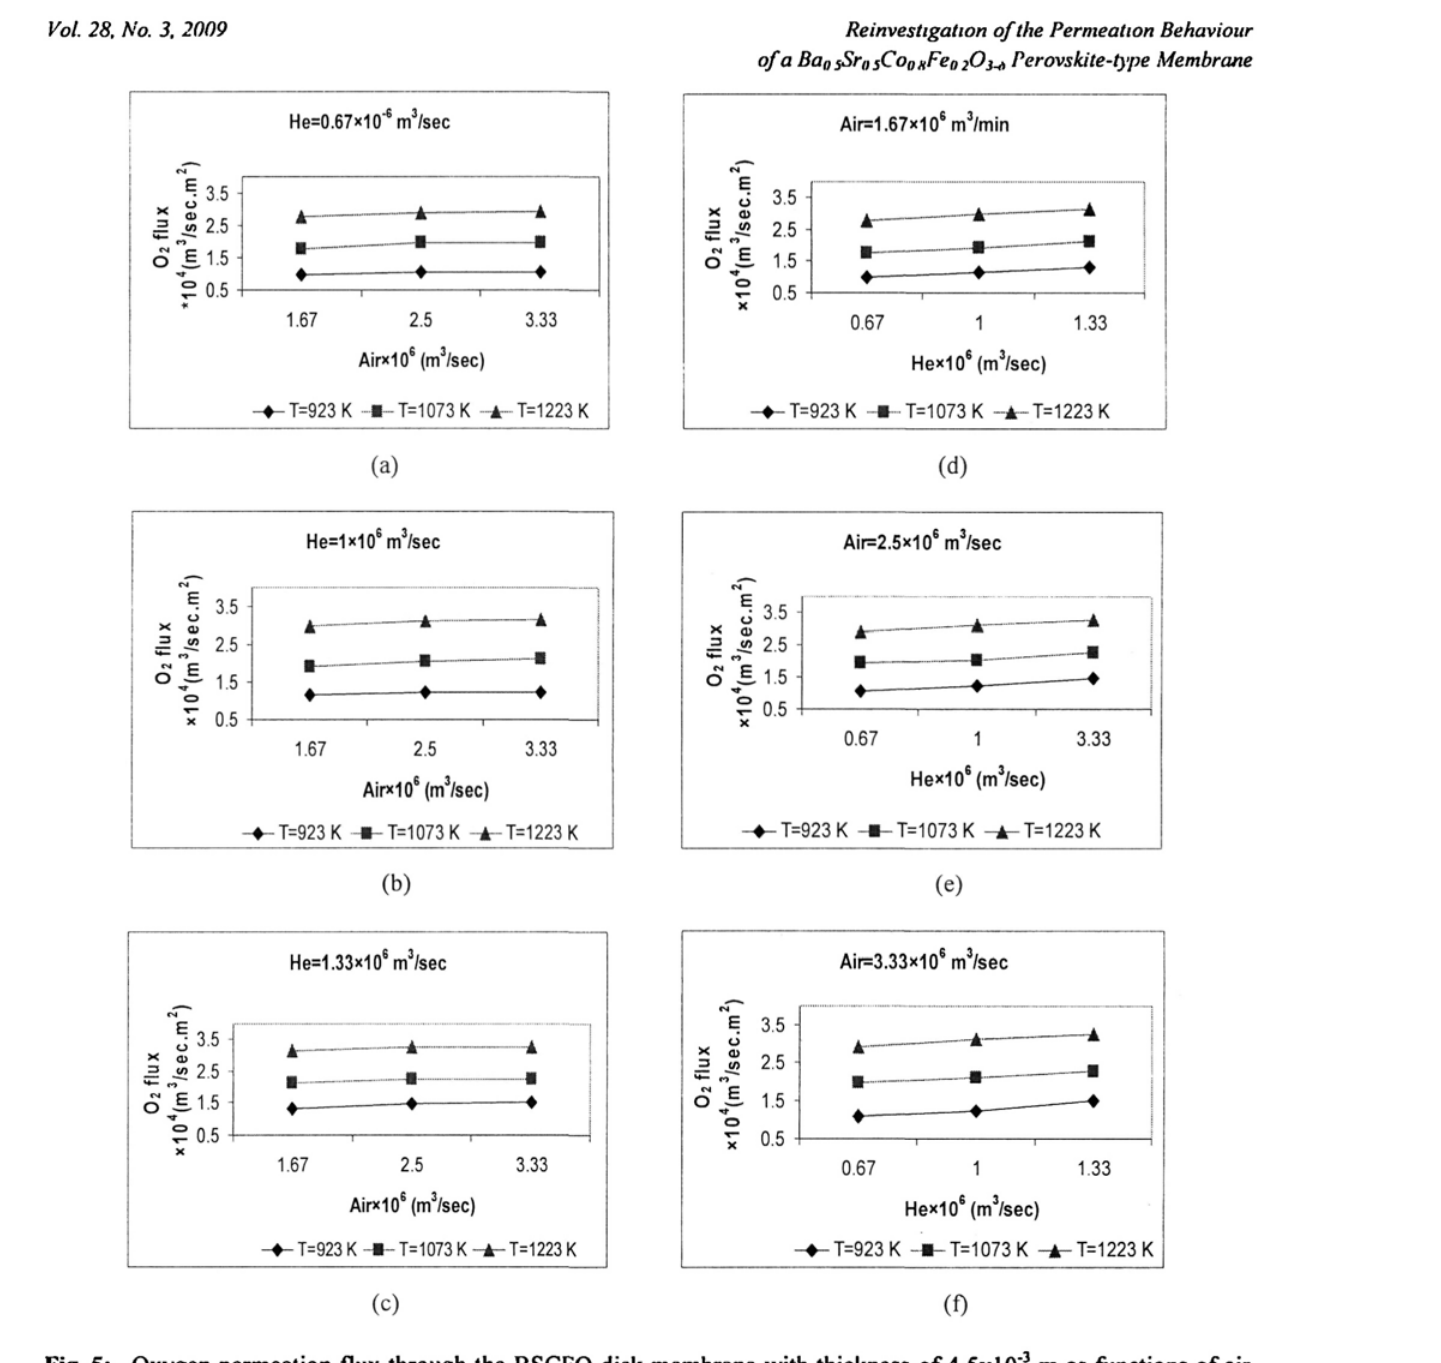
Fig. 5: Oxygen permeation flux through the BSCFO disk membrane with thickness of 4.5xlO" 3 m as functions of air flow rate (a, b and c) in upstream side and helium flow rate in downstream side (d, e and